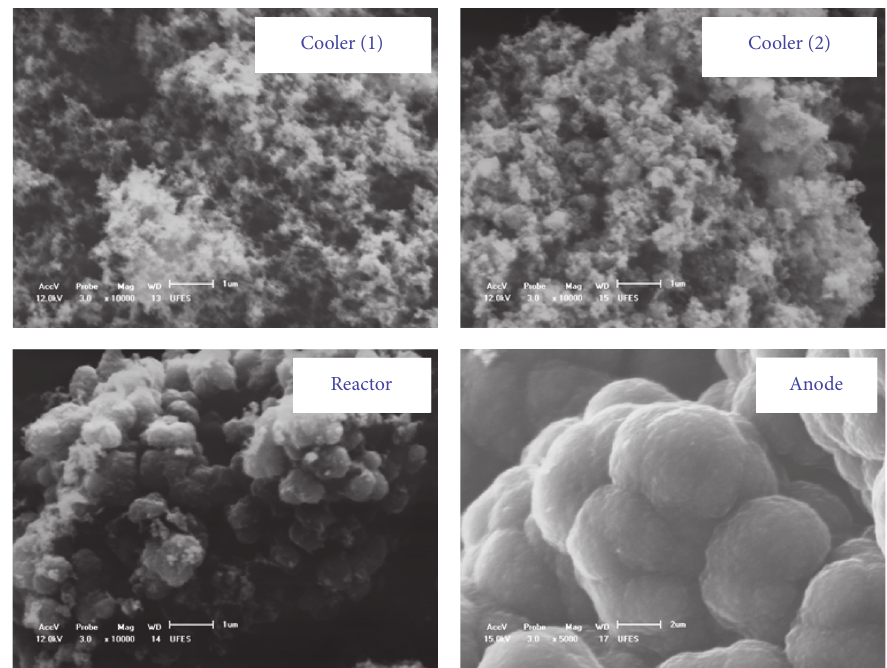
Figure 4: SEM images of the carbon residues collected at different points in the Ar plasma apparatus.